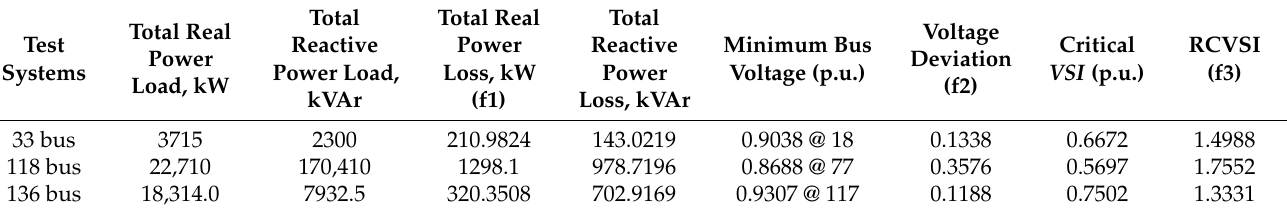
Table 2. Base case performance of the test systems.